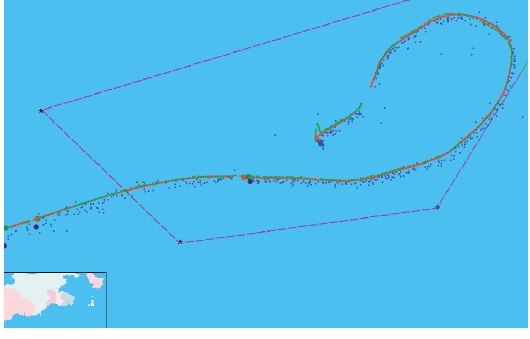
Figure 17. Vessel trajectory for the dynamic positioning experiment.